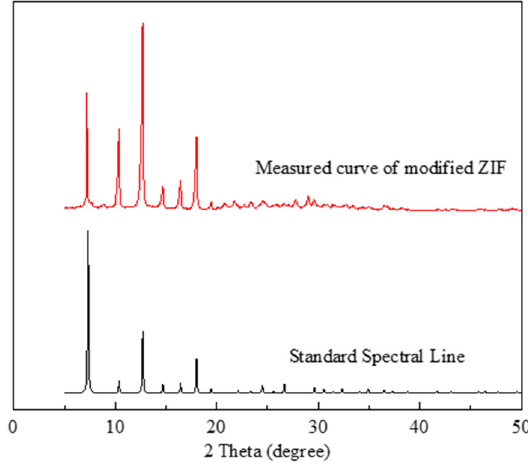
Figure 2. XRD pattern of the modified ZIF.